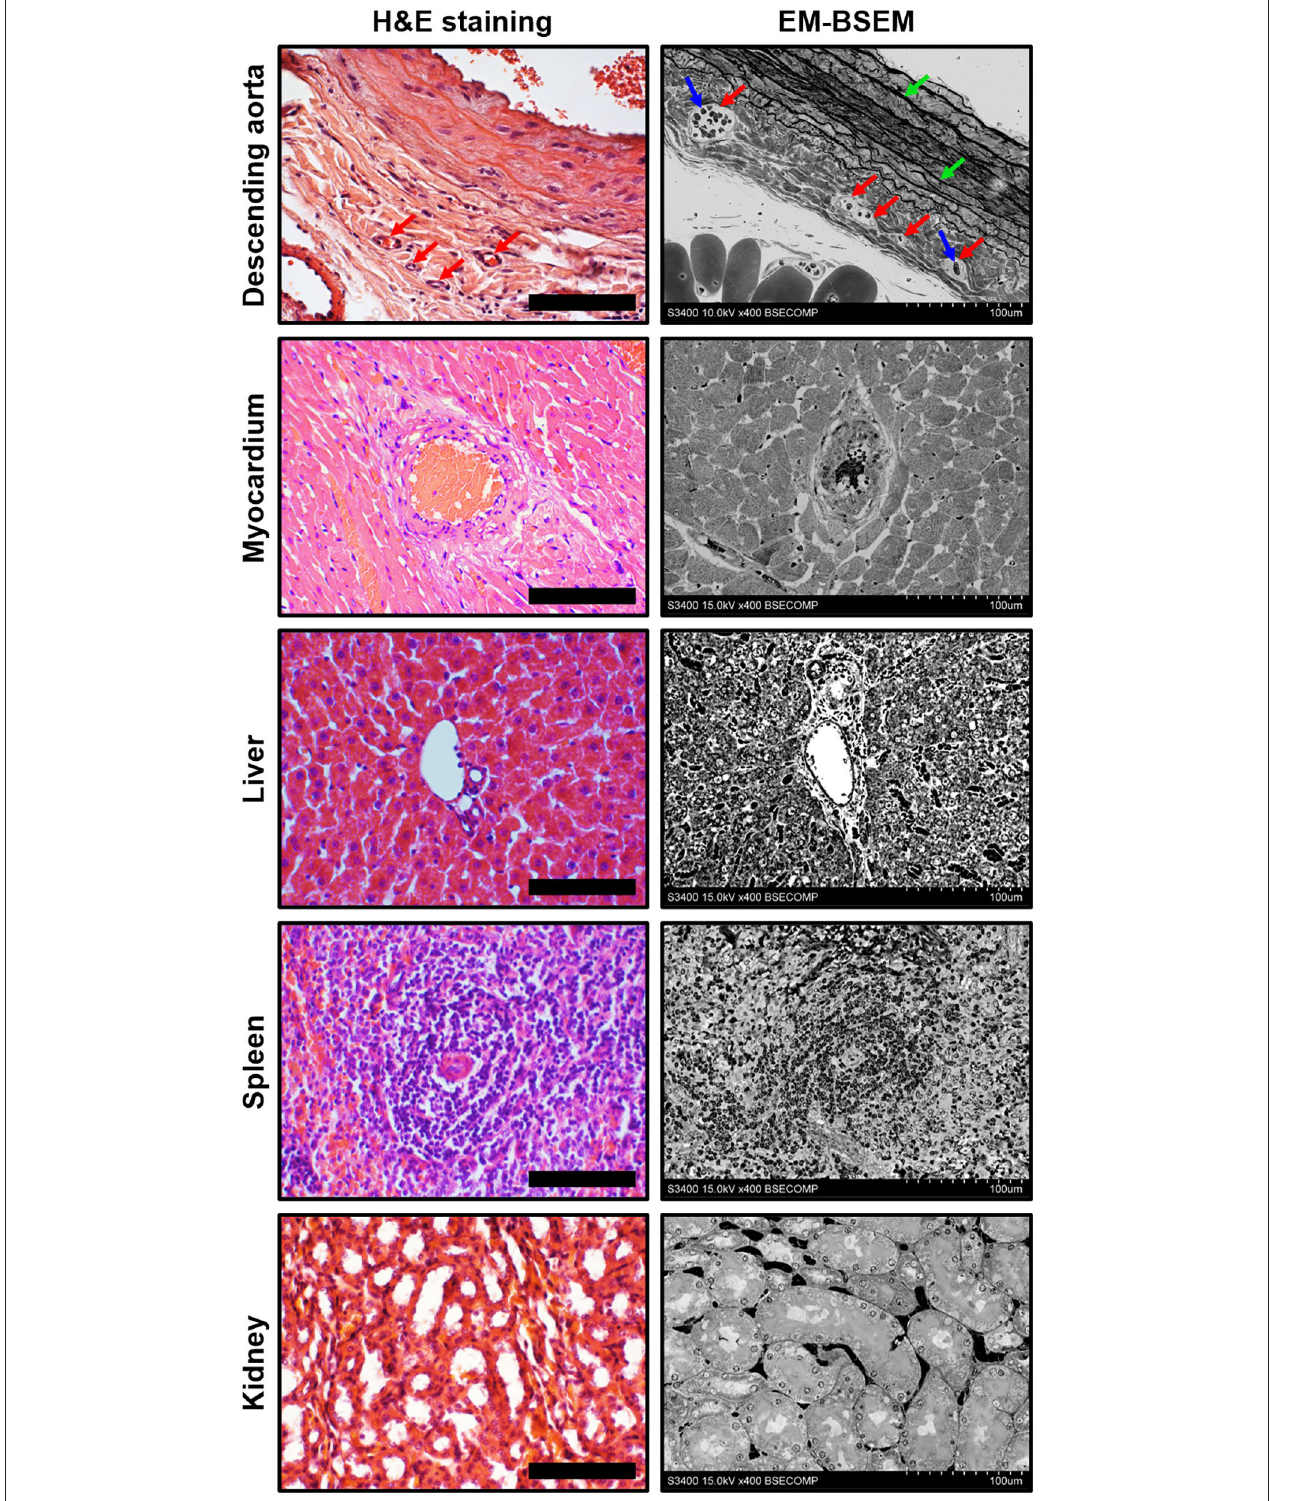
FIGURE 4 | Side-by-side comparison of H&E staining and EM-BSEM of rat descending aorta, myocardium, liver, spleen, and kidney. Scale bar (100 µ m) and magnification ( × 400) for H&E staining (left side) are equal to those on the BSEM images (right side). Accelerating voltage was 15 kV for all BSEM images, except that of the descending aorta (10 kV). The vasa vasorum in the tunica adventitia of the descending aorta are indicated by red arrows, while the red blood cells inside their lumen and elastic fibres are indicated by blue and green arrows, respectively.